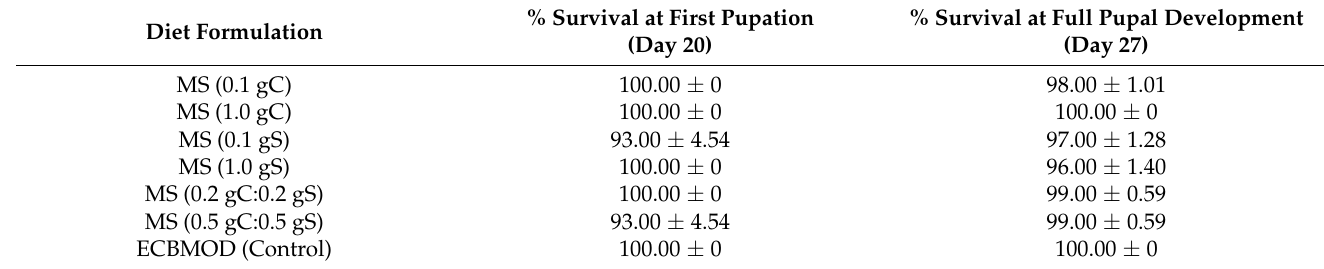
Table 3. Mean ( ± SE) survival of Eldana saccharina life stages reared on the MS (0.1 gC), MS (1.0 gC),